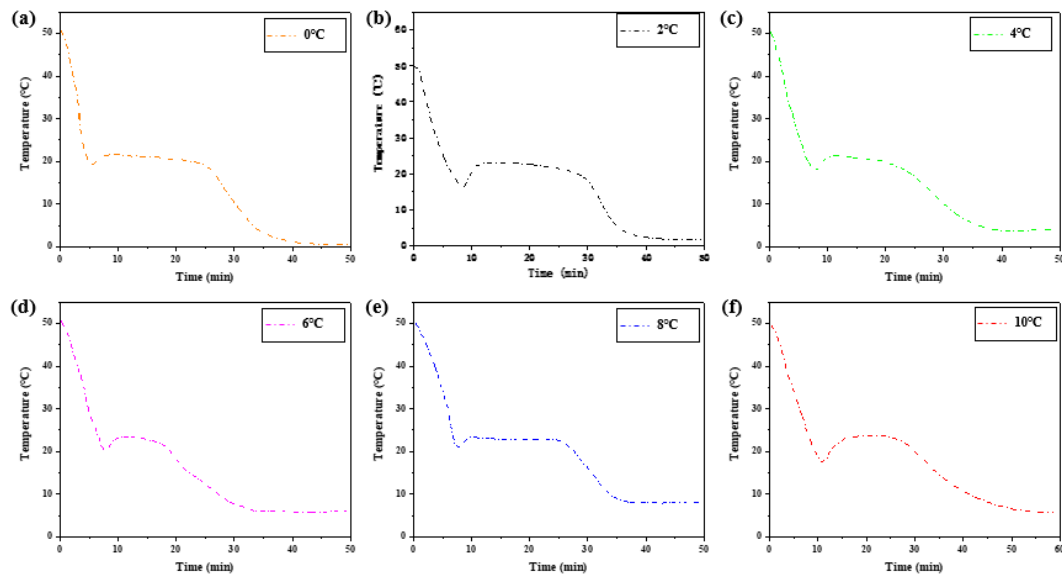
Figure 10. The exothermic process at different cooling temperatures.